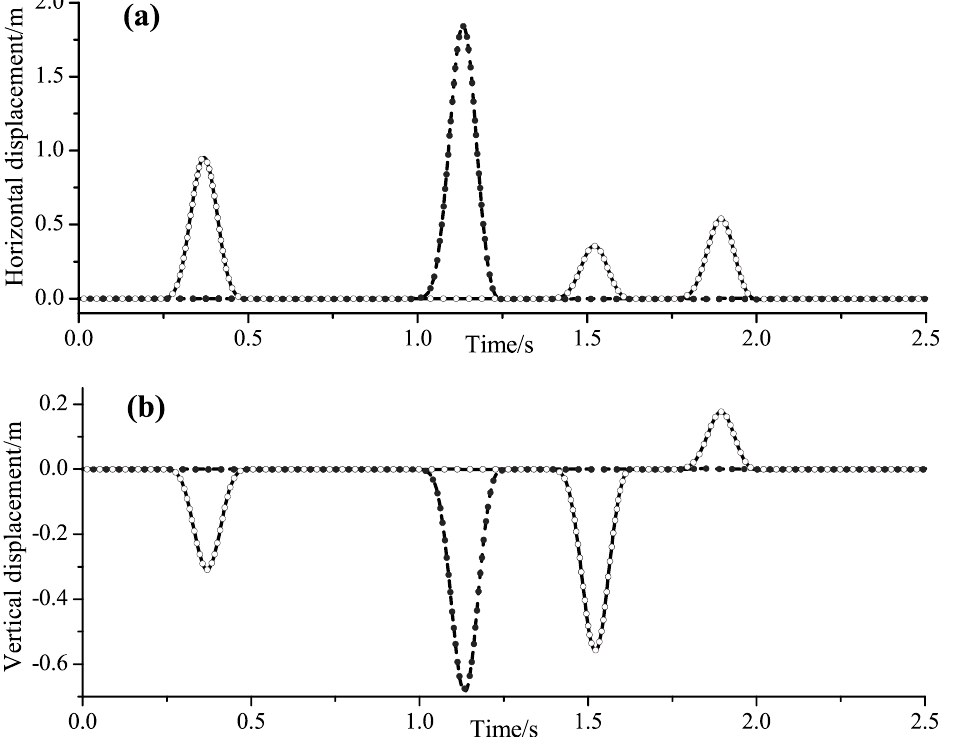
Figure 8. Displacement time history at observation points of incident SV waves: ( a ) horizontal displacement, and ( b ) vertical displacement (solid lines and dashed lines are numerical results of points A and B, respectively, with circles showing analytical solutions).